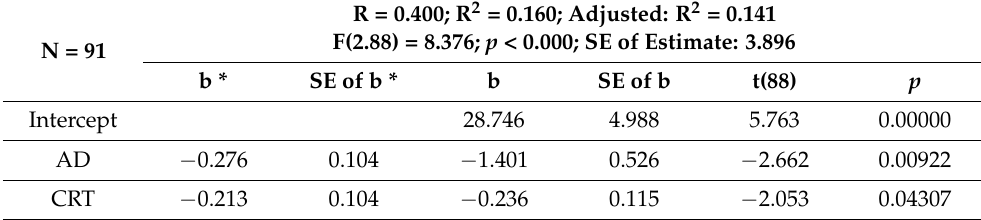
Table 2. Multiple regression—predictors of game effectiveness in attack.